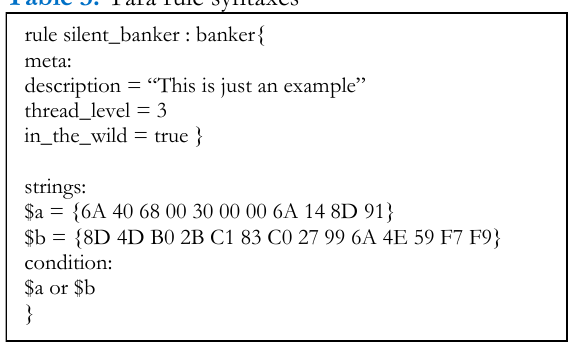
Table 3. Yara rule